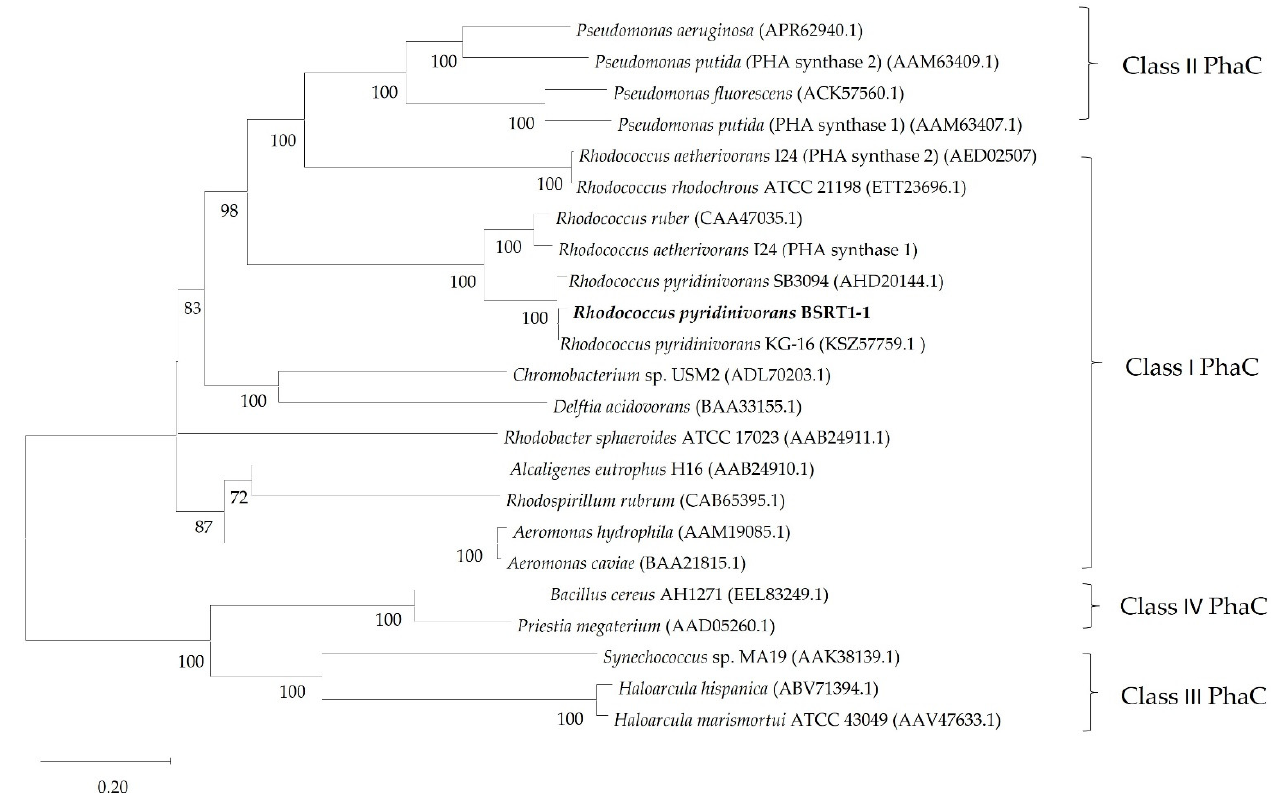
Figure 1. Neighbor-joining phylogenetic tree of PhaC amino acid sequence of R. pyridinivorans BSRT1-1 and closely related taxonomic group using amino acid sequence achieved from GenBank database. Numbers at nodes indicate levels of bootstrap support (%) according to the neighbor-joining analysis of 1000 resampled datasets; only values ≥ 50% are given. Bar, 0.20 substitutions per site.